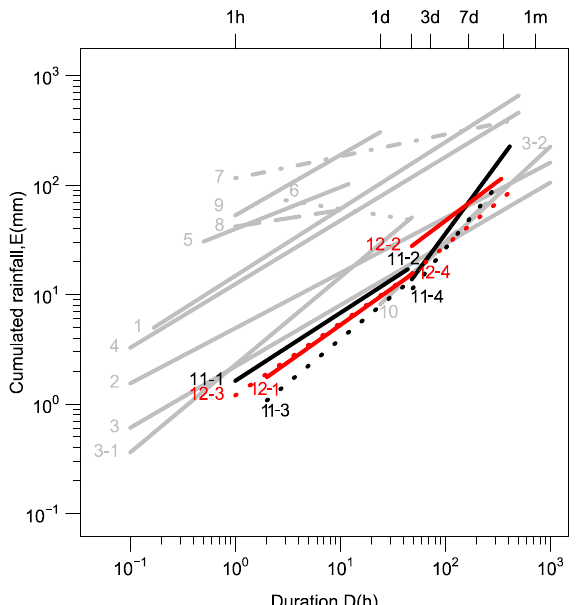
Figure 5. Comparison between E–D thresholds defined in this work and previous published thresholds. The numbers refer to No. in Table 3.